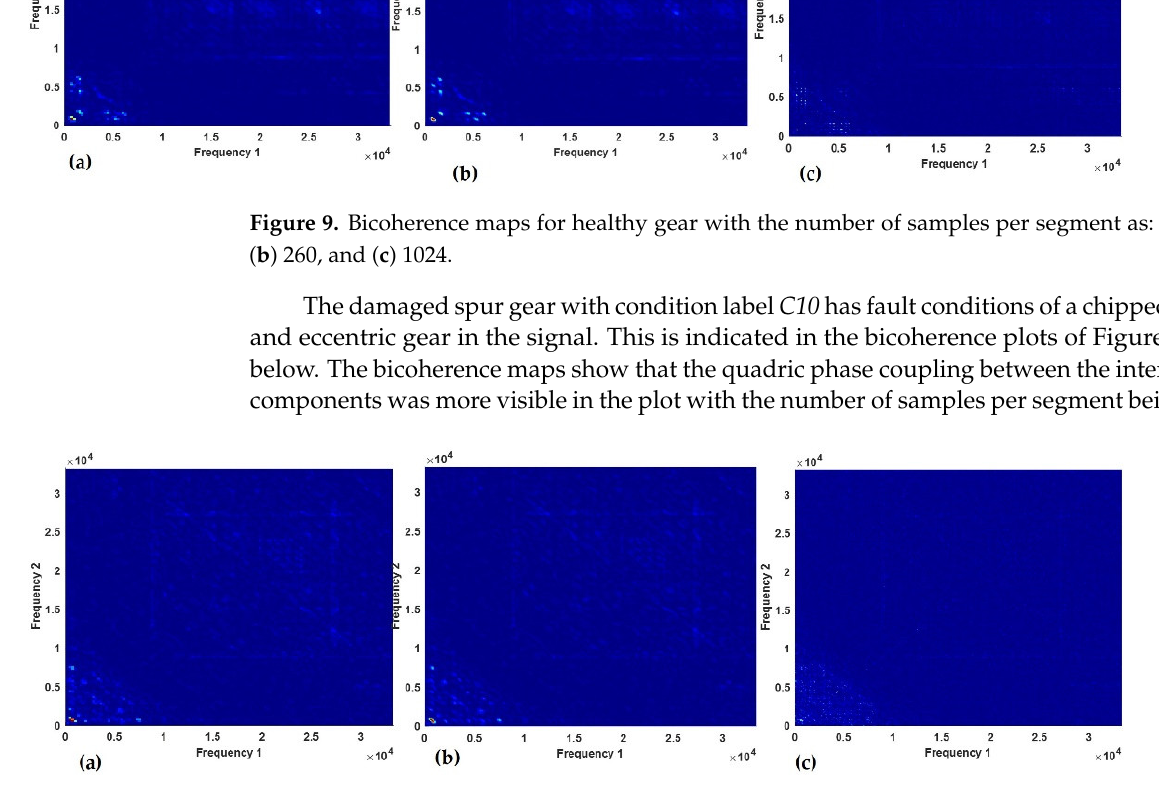
Figure 10. Bicoherence maps for C10 with the number of samples per segment as: ( a ) 256, ( b ) 260, and ( c )